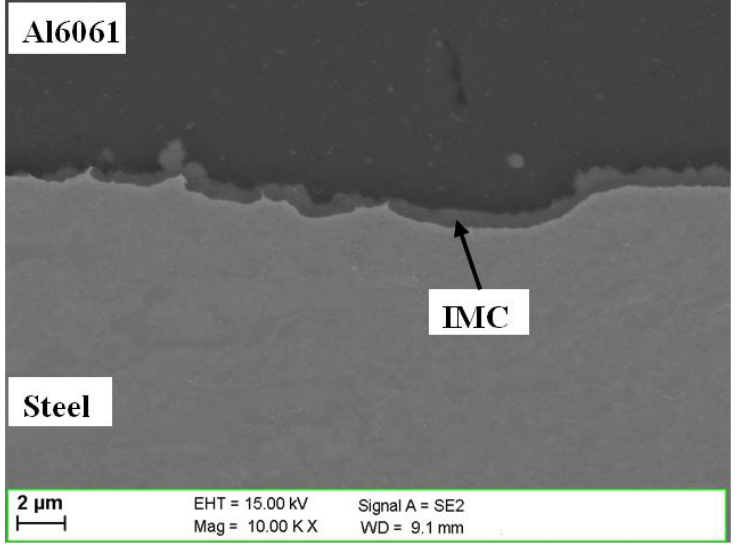
Figure 8. SEM observation of welded joint by friction stir welding of aluminum alloy AL6061-T6 to ultra-low carbon steel. Advancing speed = 200 mm/min. IMC: intermetallic compound. Table 3. Chemical composition of IMC layer.